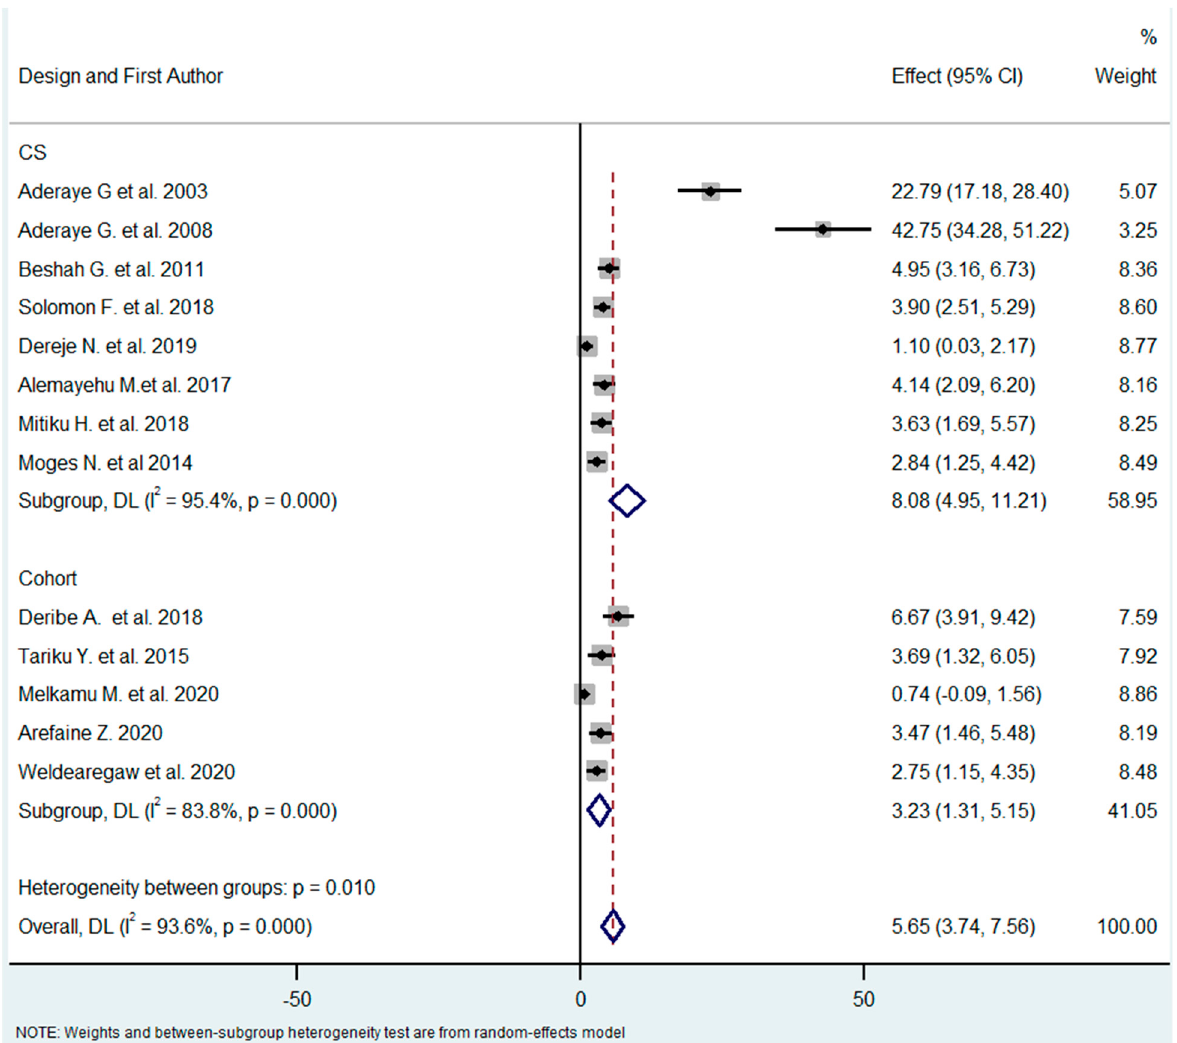
Figure 3. Subgroup analysis by study design [18,21,26–36].